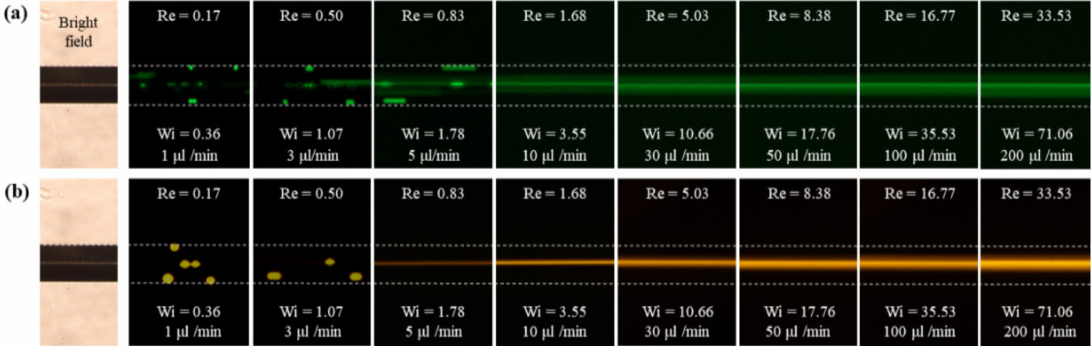
Figure 4. Fluorescence image of the rhombic microchannel containing the viscoelastic fluid (consisting of an aqueous solution of PEO500) at various flow rates: ( a ) 5 µ m particles; ( b ) 13 µ m